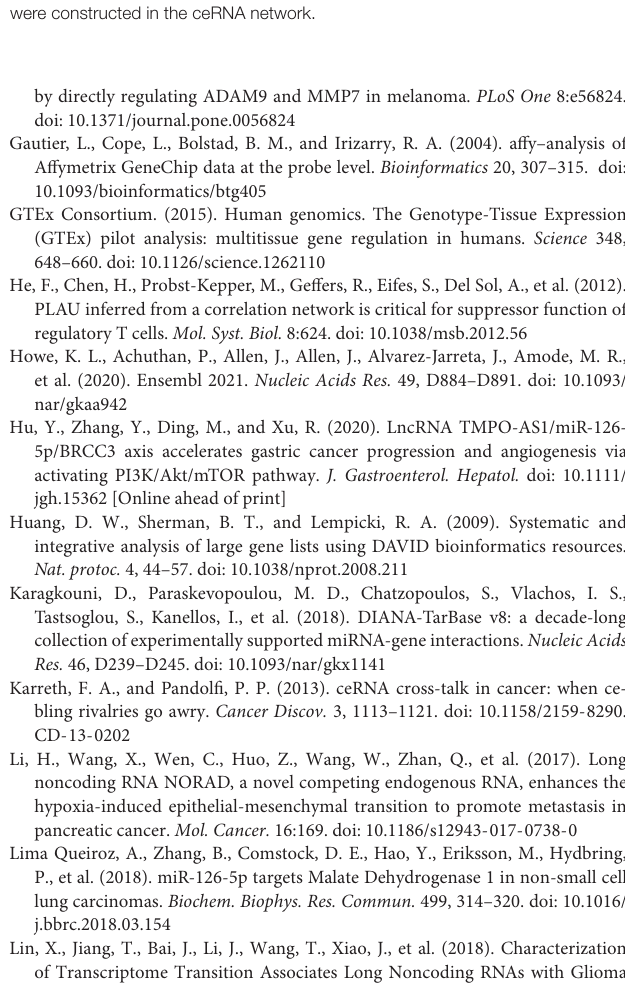
AGTR1, OLR1, TEK, and TLR4 through OncoLnc database, respectively ( ∗ P < 0.05). Supplementary Figure 4 | Validating the expression level of candidate miRNAs in LUAD. (A–E) the expression level of hsa-miR-126-5p, hsa-miR-145-5p, hsa-miR-181-5p showed relatively low value in starbase, whereas hsa-let-7i-5p, hsa-miR-21-5p proved a relatively low expression. Supplementary Figure 5 | Validating the survival outcome of candidate miRNAs in LUAD. (A–E) hsa-miR-126-5p, hsa-miR-145-5p, hsa-miR-181-5p showed the prolonged survival, whereas hsa-let-7i-5p, hsa-miR-21-5p proved a dismal prognosis in LUAD. Supplementary Figure 6 | Screening and validating the expression level and prognostic value of meaningful lncRNAs in LUAD. (A–I) High expression of HOTAIR, TMPO-AS1, LINC00707, IGFL2-AS1, LINC00665, and LUCAT1 were related to a dismal prognosis, whereas low expression of CARD8-AS1, CARMN, and LINC00885 were associated with prolonged survival. Supplementary Table 1 | Differentially expressed genes (DEGs) and immune-related genes (IRGs) in our analysis. Supplementary Table 2 | The mRNA-miRNA pairs predicted by the TarBase database. Supplementary Table 3 | The miRNA-lncRNA pairs predicted by the miRNet database. Supplementary Table 4 | The qualified lncRNA-miRNA and miRNA-mRNA pairs were constructed in the ceRNA network.